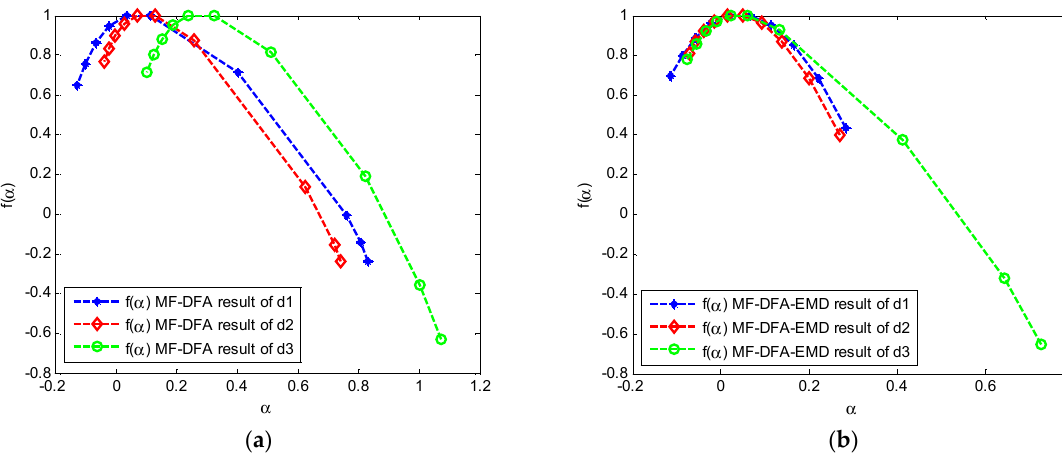
Figure 6. 𝛼 − 𝑓(𝛼) curves of three signal components obtained using: ( a ) the traditional multifractal detrended fluctuation analysis (MFDFA) algorithm; and ( b ) the new MFDFA algorithm.